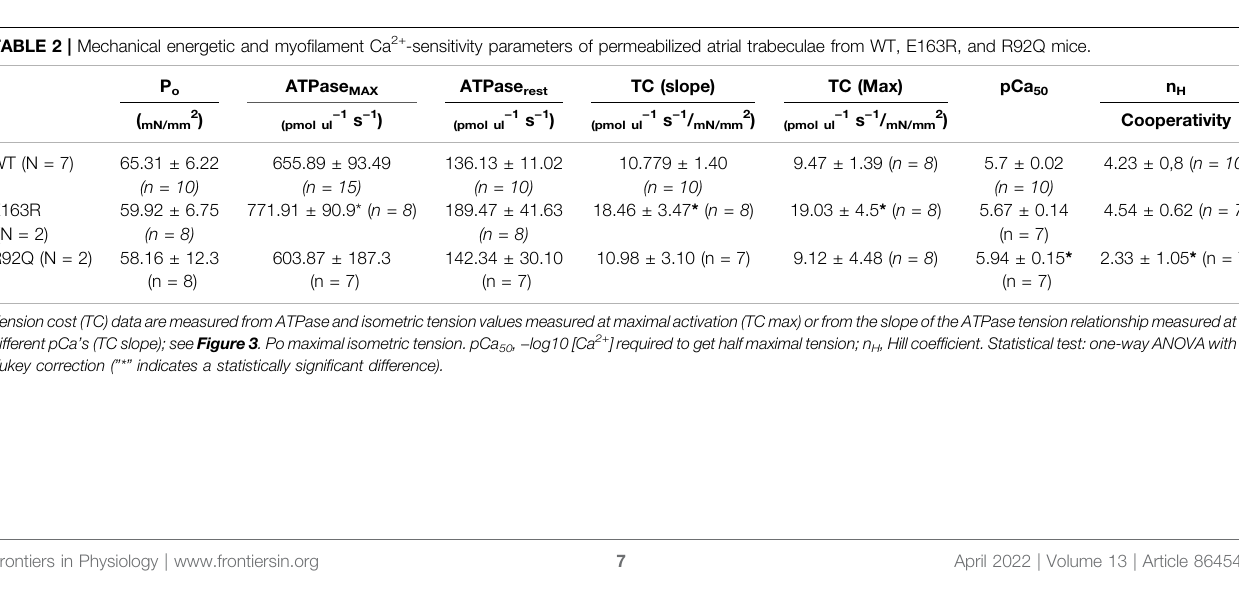
TABLE 2 | Mechanical energetic and myo fi lament Ca 2+ -sensitivity parameters of permeabilized atrial trabeculae from WT, E163R, and R92Q mice. P o ATPase MAX ATPase rest TC (slope) TC (Max) pCa 50 n H ( mN/mm2 ) (pmol ul − 1 s − 1 ) WT (N = 7) 65.31 ± 6.22